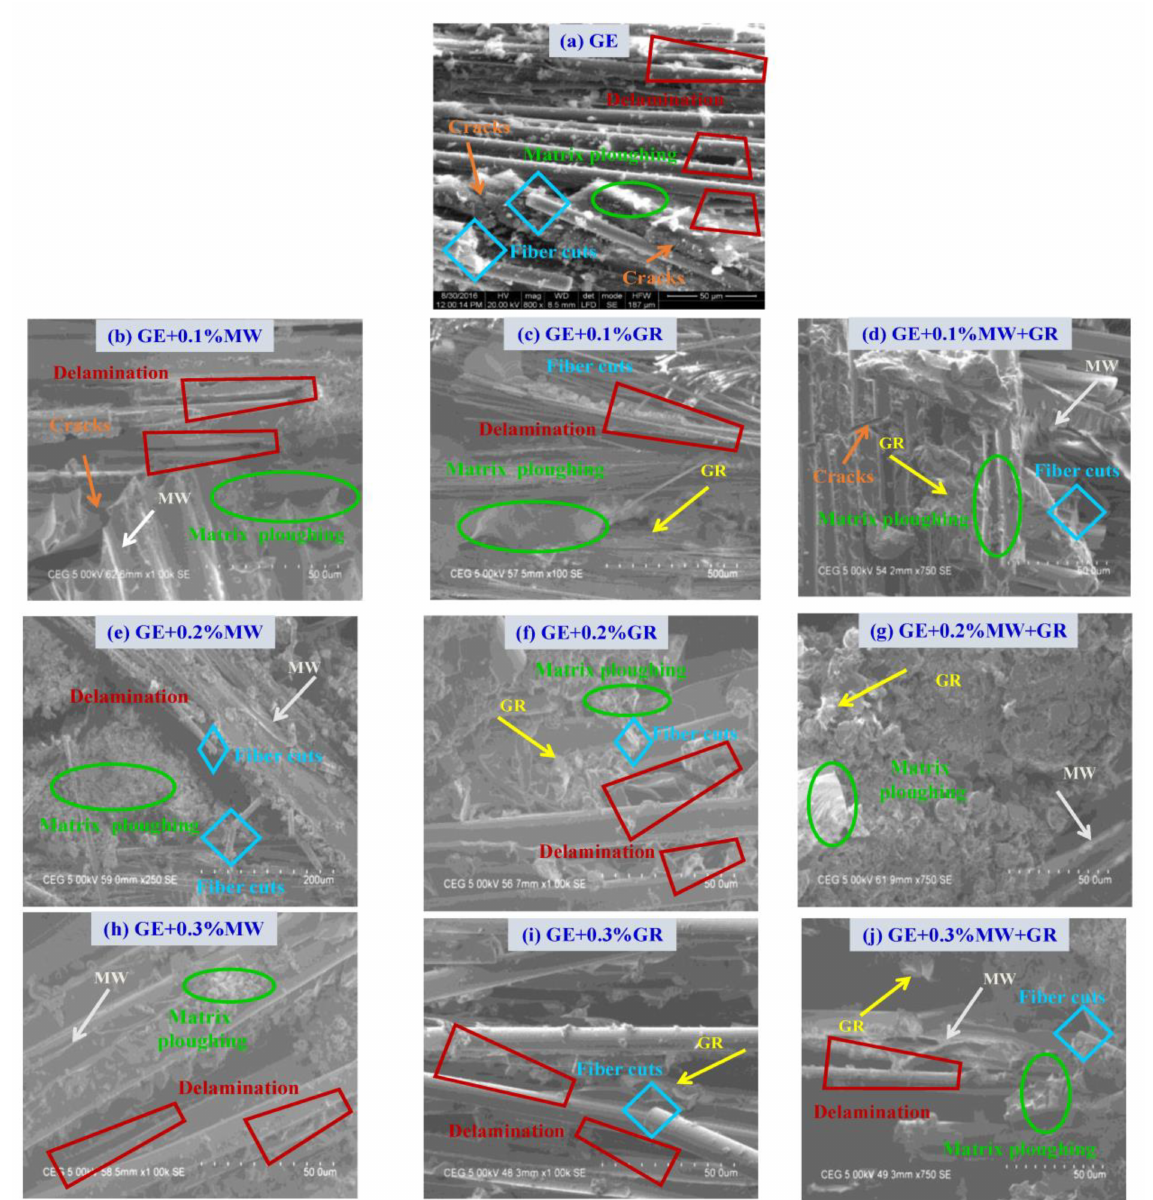
Figure 13. SEM micrographs of flexural failure in GE and its nanocomposites